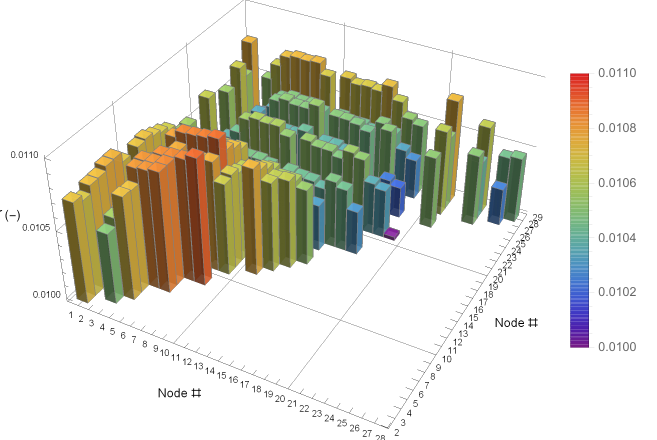
Figure 13. IEEE 39 bus: Damping ratios for VSCs with ROCOF VSG control connected to differ- ent nodes.